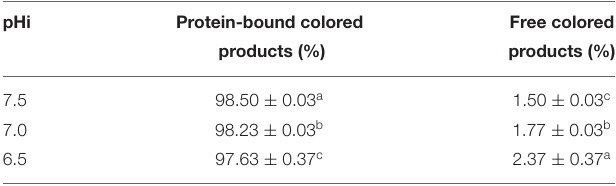
TABLE 1 | Protein-bound and free-colored products of the DL prepared at different pH i .